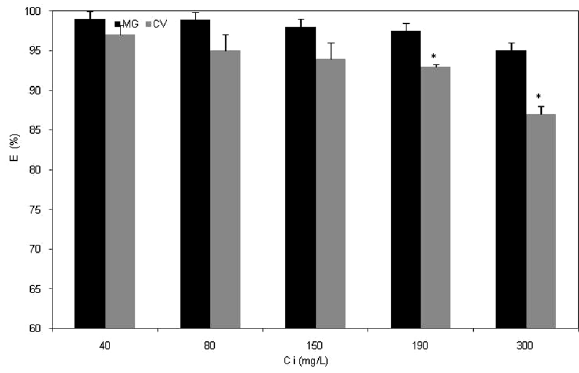
Fig. 2. The effect of the initial dye concentrations on the Lemna mi- nor dye removal efficiency; C fresh weight), V = 250 mL, T = 23 ± 2 °C, until 14 days; values mean ± standard deviations (n = 3); *significant difference at P <